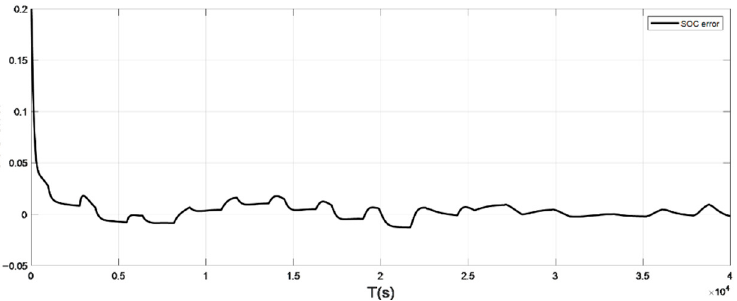
Figure 13. The SOC estimation error under constant current discharge (normal temperature: 25 ◦